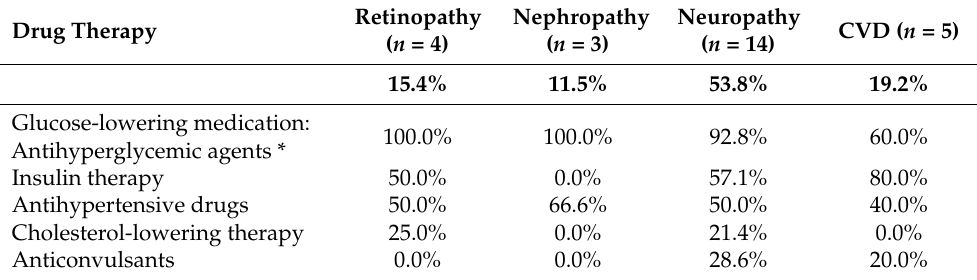
Table 2 summarizes the distribution of micro- (retinopathy, nephropathy, and neuropa- thy) and macro- (stroke, heart failure, and peripheral arterial disease) vascular complica- tions in the T2DM + C group. Different applied therapies are also indicated. Table 2. Types of VCs and medications in the T2DM + C group. Drug Therapy